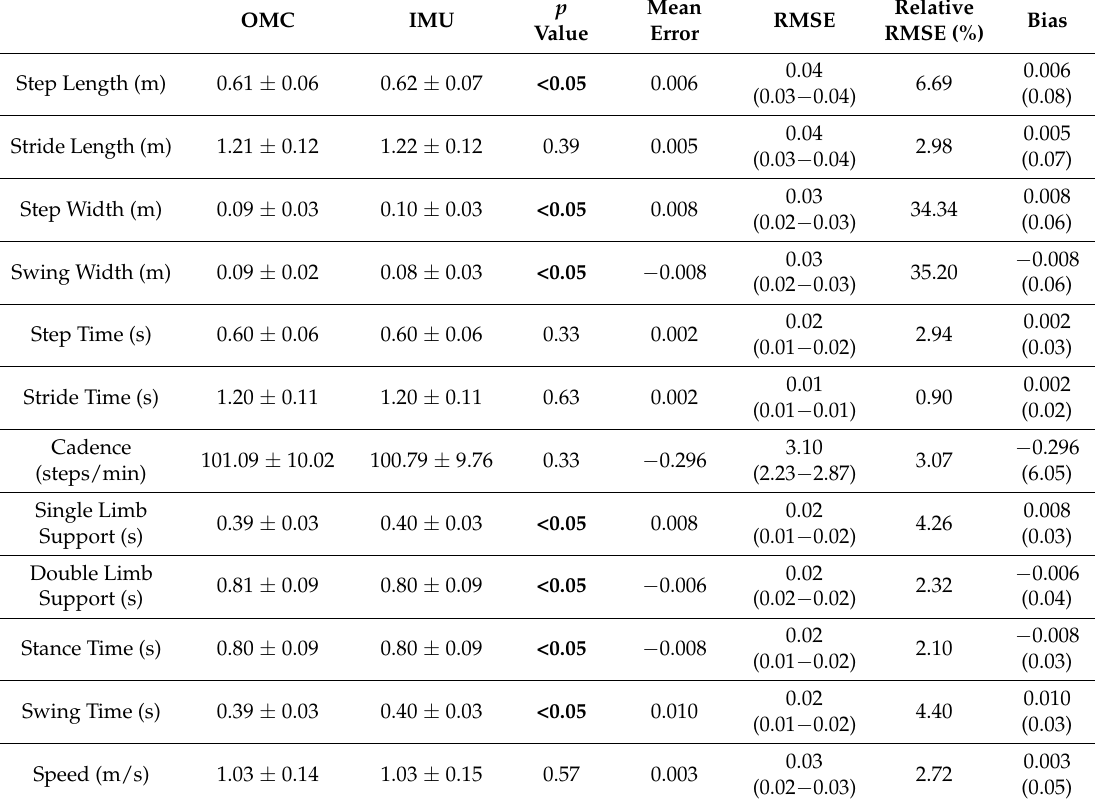
Table 3. Summary of the results of all STP. The mean parameters plus SD, p-values, mean error, root mean square error (RMSE) (95% confidence interval (CI)), relative RMSE and bias (SD) are shown. Bold p values indicate significant differences between the systems ( p <